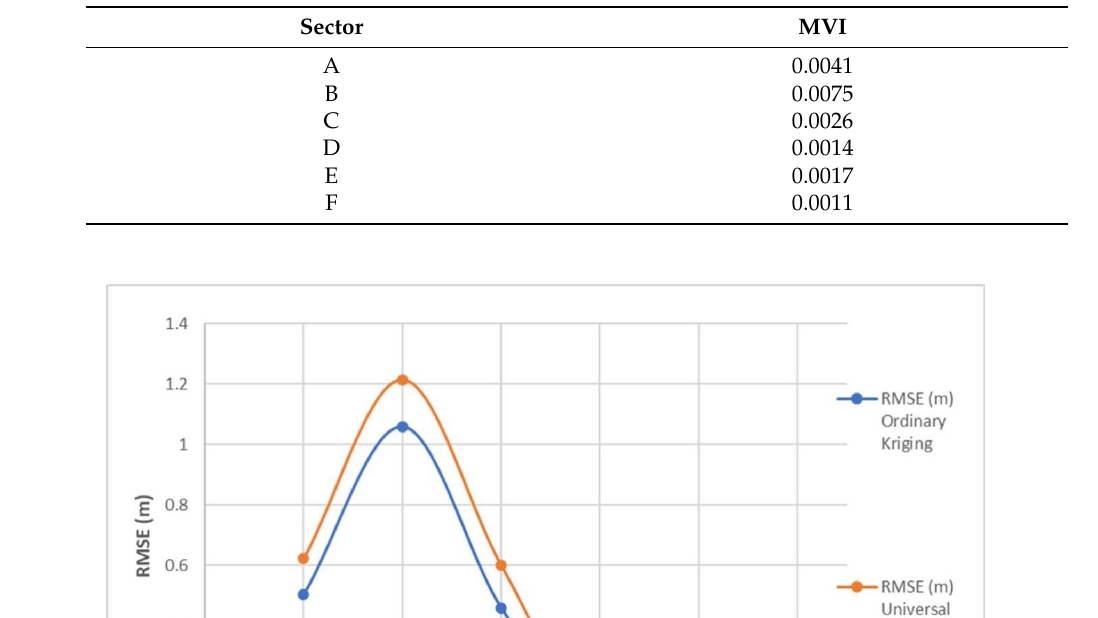
Table 9. Morphological variation index (MVI) achieved for each sector.